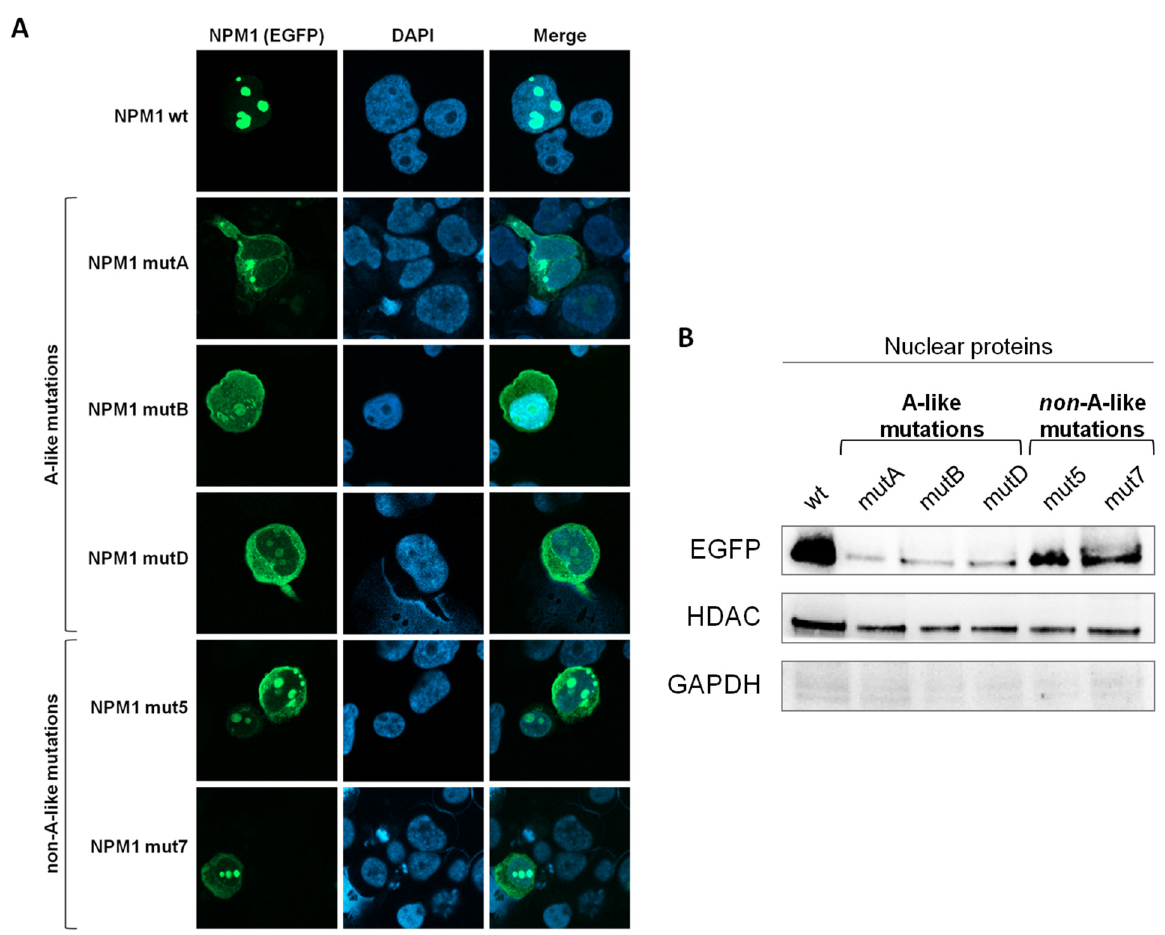
Figure 1. Intracellular localization of mutated NPM1. ( A ) Immunofluorescence of HL-60 AML cells transfected with pEGFP-NPM1wt, pEGFP-NPM1mutA, pEGFP-NPM1mutB, pEGFP-NPM1mutD, pEGFP-NPM1mut5, and pEGFP-NPM1mut7 plasmids, where EFGP is fused to NPM1. EGFP signal (green) represents NPM1 protein, and nuclei are stained with DAPI (blue) (40 × magnification, scale bar = 15 µ m). ( B ) Western blot showing EGFP protein on nuclear fraction of EGFP positive HL-60 cells transfected with pEGFP-NPM1wt, pEGFP-NPM1mutA, pEGFP-NPM1mutB, pEGFP-NPM1mutD, pEGFP-NPM1mut5, and pEGFP-NPM1mut7 plasmids. The whole western blot images are in Figure S5.